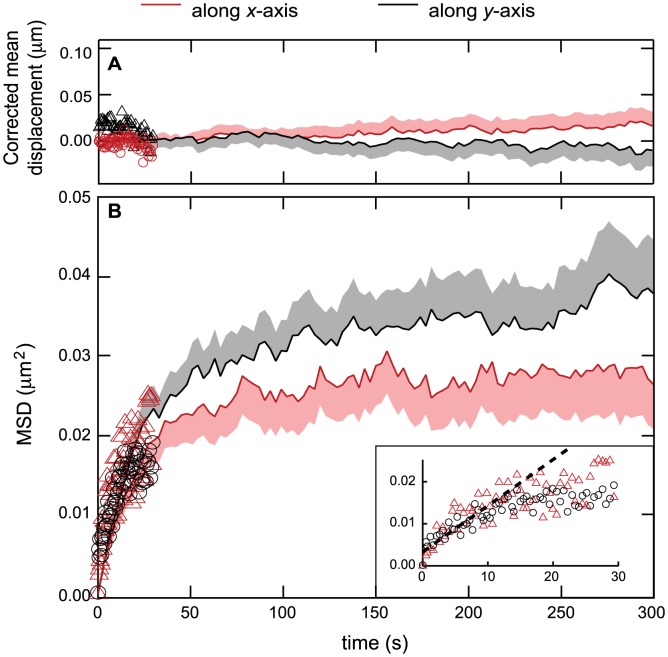
Single-aggregate tracking analysis inside E. coli cells.Coordinates along the x and y-axis are shown in red and black, respectively. Low frequency sampling trajectories (LF) are displayed using full lines and high frequency ones (HF) using open symbols. Light red and black swaths indicate + and −95% confidence intervals for the x- and y-axis data, respectively (for clarity, − and + intervals for the x- and y-axis data, respectively, are omitted) (A) Corrected mean displacement  where uc(t) is the applied correction. For the y-component, the correction is the time-average of the y-coordinate. For the x-component, the applied correction is cell growth :  where L(t) is the cell half-length at time t and Δt is the time interval between two consecutive images. (B) Corresponding mean squared displacements . The inset shows a magnification of the HF results and their close-to-linear behavior for the first 10–15 seconds (dashed line).